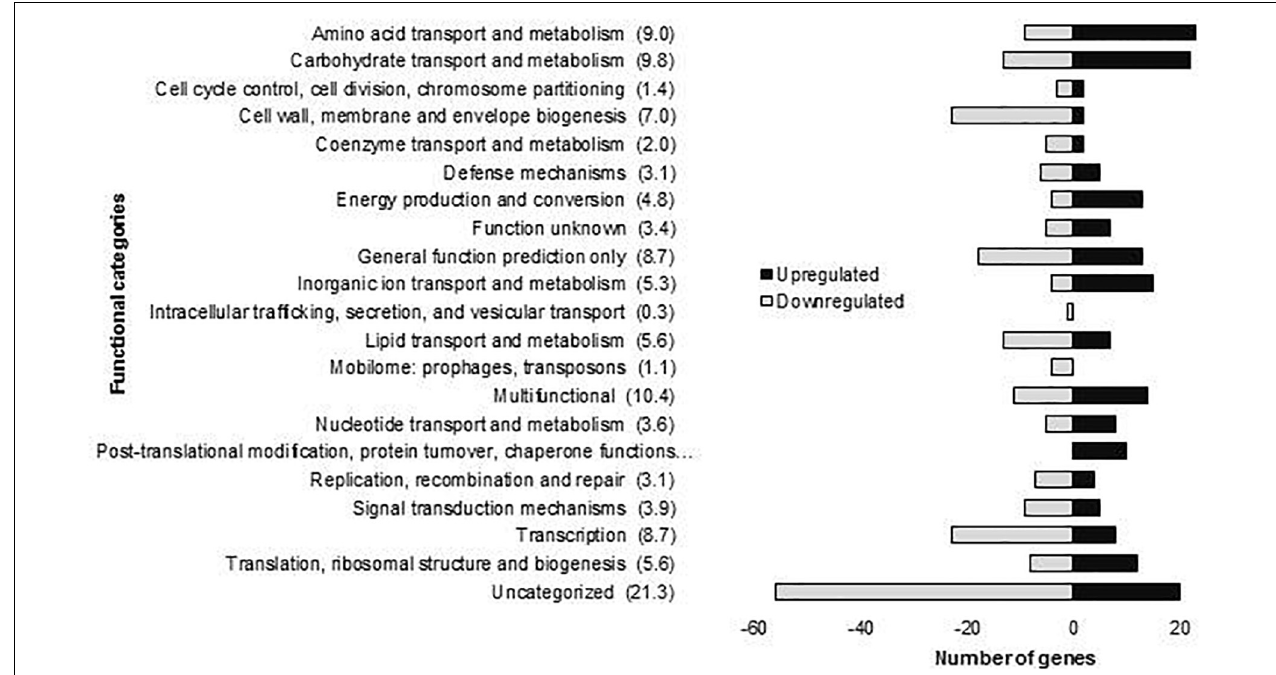
FIGURE 1 | Number of L. plantarum WCFS1 genes by functional categories that were upregulated and downregulated in the presence of 15 mM oleuropein. The number in parentheses represents the percentage of differentially expressed genes in each